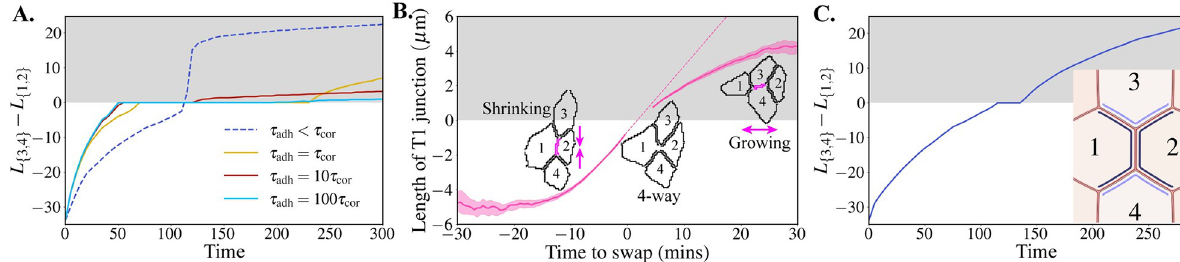
Fig 5. The adhesion timescale regulates junction shrinkage, resolution and extension dynamics. (A) Signed length of T1 junction (negative when {1, 2} shrinking; positive when {3, 4} growing, grey shading) vs. simulation time-step. (B) Experimental data of signed length of T1 junction vs. time to neighbour exchange swap for wild-type cells in the Drosophila germ-band. The data was extracted from experiments originally published in [25]. Lengths below 0.75 μ m are not plotted, due to insufficient imaging resolution. Dashed line shows continuation of shrinkage speed from 5 mins before swap, with gradient 0.38 μ m/min, which meets re-emergence of solid line after swap, indicating a minimal delay during the resolution phase. Shading represents 95% confidence intervals. (C) Signed length of T1 junction vs. simulation step for a simulation where contractility is applied asymmetrically along bicellular junctions neighbouring the shrinking junction. Cortices next to darker (or lighter, resp.) blue lines in snapshot have γ = 0.99 (or 0.9975, resp.). See also S9